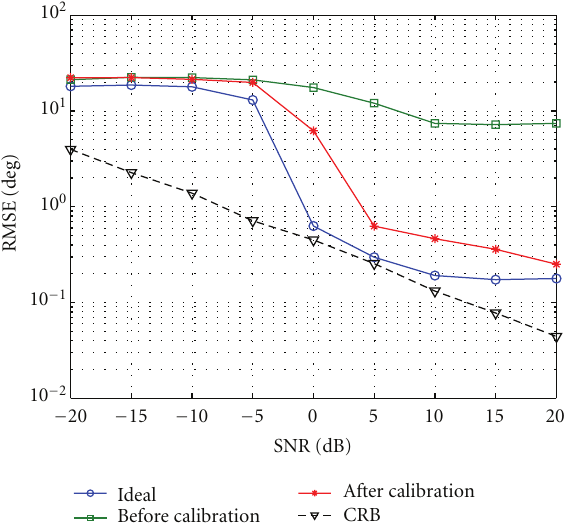
Figure 5: RMSE of the DOA estimation versus